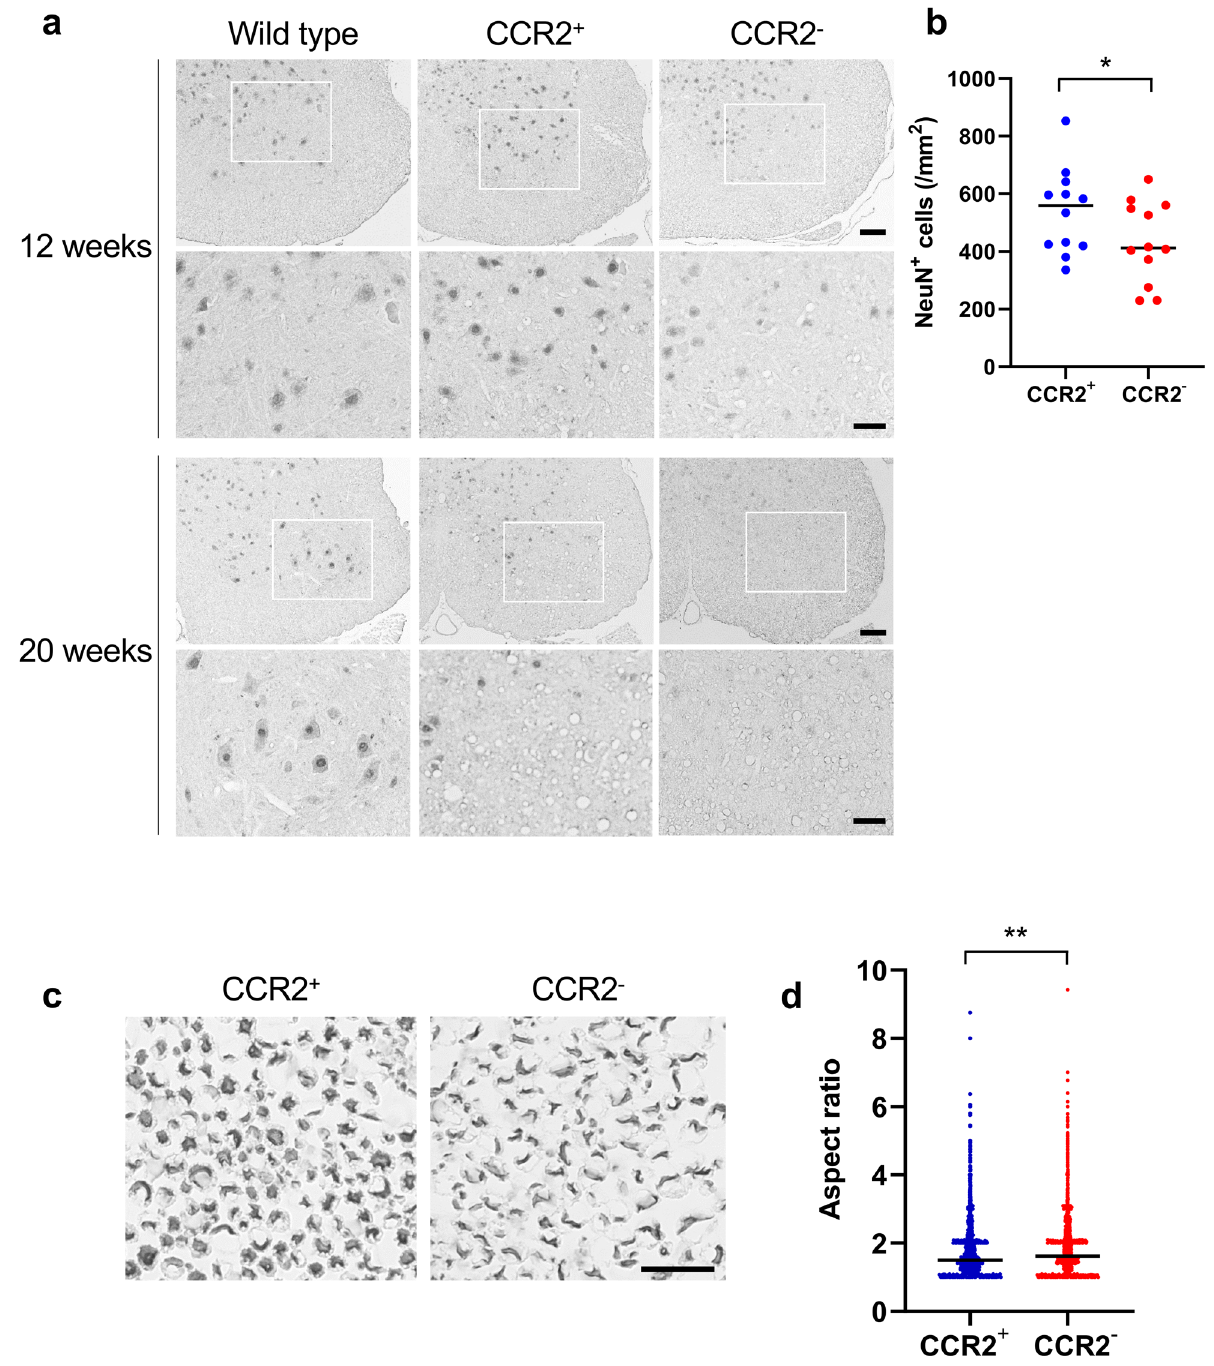
Figure 5. Facilitation of neuro-axonal degeneration by CCR2 ablation. ( a ) NeuN immunostaining revealed increased anterior horn neuronal cell loss in CCR2-deficient SOD1 G93A mice compared with CCR2-positive SOD1 G93A mice at 12 and 20 weeks of age. Inset areas in the low magnified images are enlarged under each figure. ( b ) CCR2-deficient SOD1 G93A mice showed a significant decrease in NeuN + cell numbers compared with CCR2-positive SOD1 G93A mice at 12 weeks of age ( p = 0.033, n = 12). ( c ) SMI 31/32 immunostaining of sciatic nerve transverse sections indicated axons in CCR2-deficient SOD1 G93A mice had crescent-shaped deformation compared with CCR2-positive SOD1 G93A littermates at 8 weeks of age. ( d ) The aspect ratio (the ratio of the major to the minor axis length) of CCR2-deficient SOD1 G93A mouse axons was significantly larger than that of CCR2-positive SOD1 G93A mouse axons at 8 weeks of age ( p < 0.001, n = 5). Scale bars: ( a ) 100 μm and 50 μm; c, 20 μm. The horizontal line represents the mean value in ( b , d ). * p < 0.05; ** p <